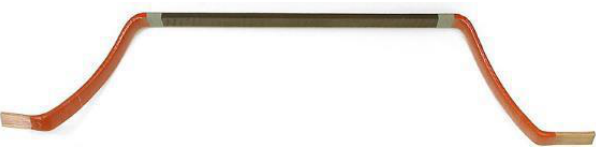
Figure 2. Illustration of the stator bar (Roebel type) used in large hydro-generators.